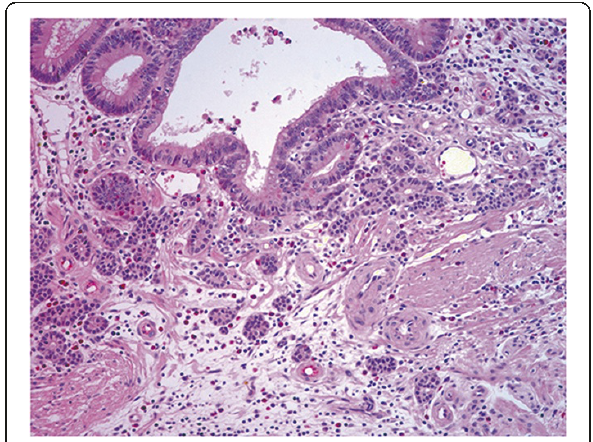
Figure 2 In the base of polyps, neuroendocrine tumor cells appeared to bud off from the basal epithelium of adenomatous glands into the lamina propria with an angulated glandular appearance. .